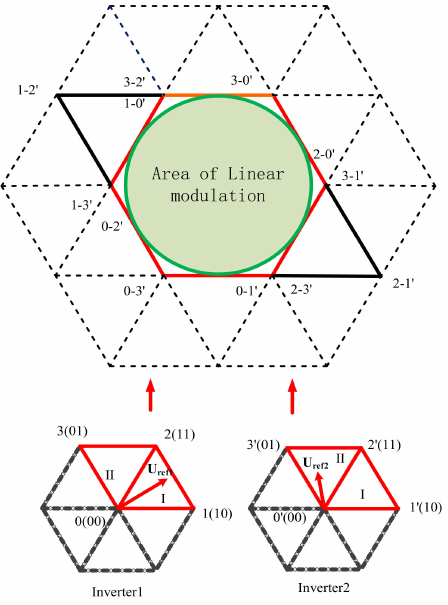
Figure 3. Distribution of the voltage vectors under the open-phase fault of